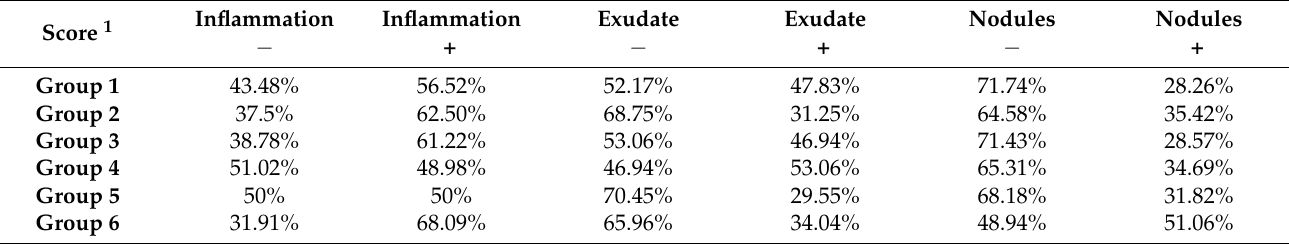
Figure 2. Oviduct lesions in the DMV/1639 challenge group: ( A ) the first cystic oviduct detected in the birds challenged with DMV, seen in a 9-week-old bird challenged at 7 DOA; ( B ) cyst in the caudal end of an oviduct from a 12-week-old bird challenged at 3 DOA; ( C ) small fluid-filled oviduct from a 13-week-old bird challenged at 7 DOA. Table 4. Histopathology Scores by